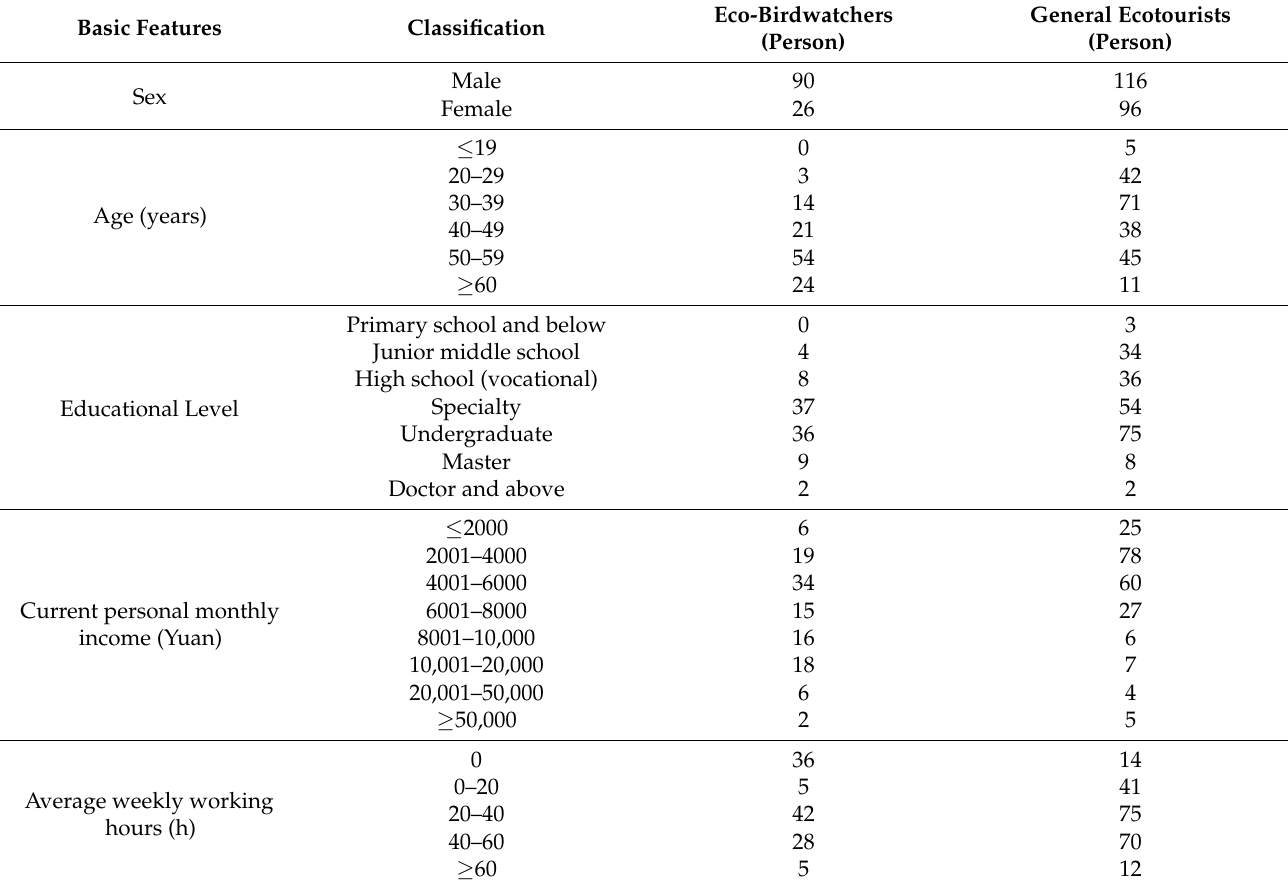
Table 2. Sample structure